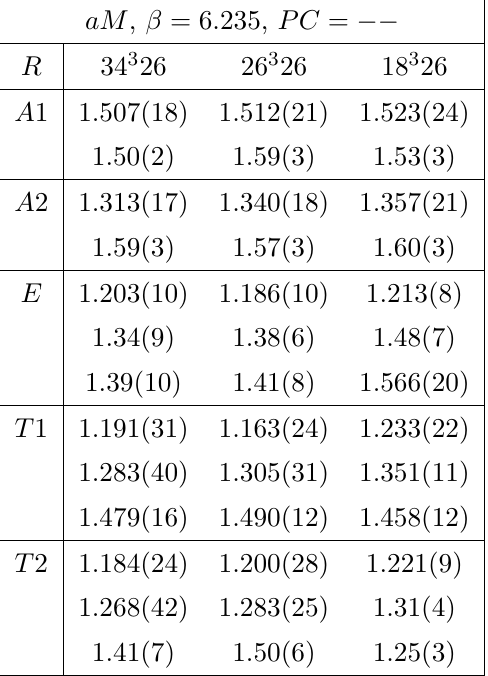
Table 6 . Finite volume check on glueball masses with P = − and C = − at β = 6 . 235 on the lattices shown. Where possible the masses are extracted from the same initial time and so are not always the same as our best mass estimates listed in other tables.